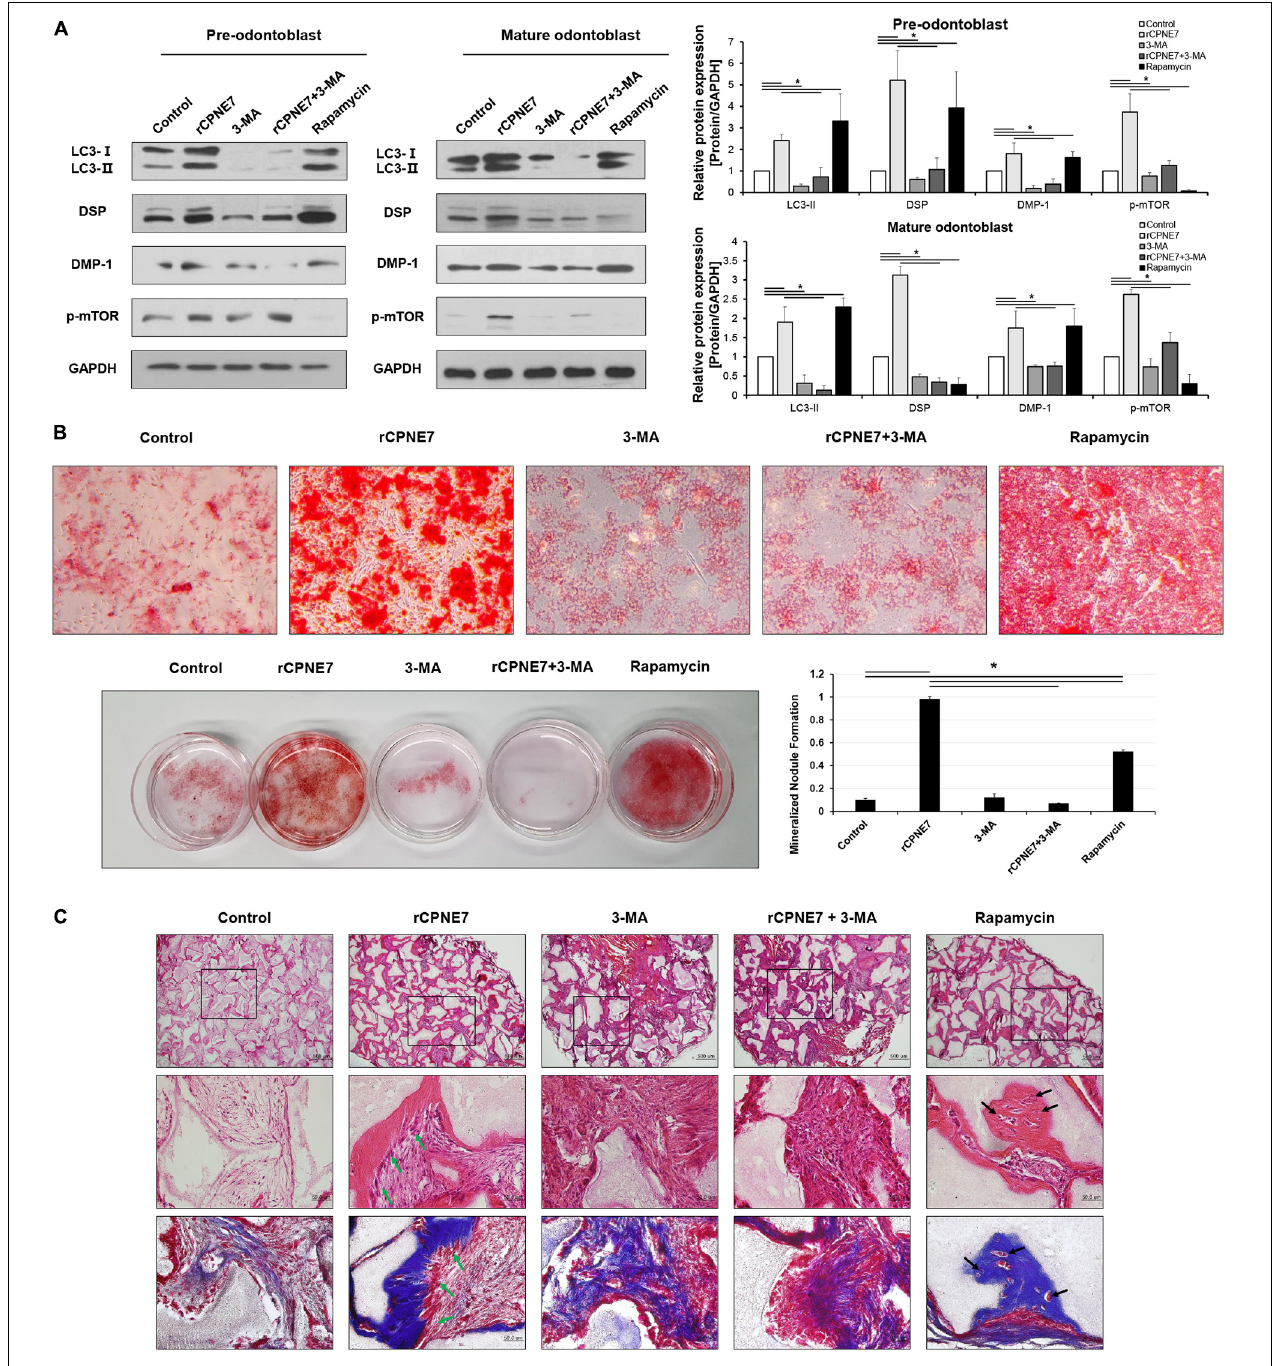
FIGURE 2 | CPNE7 promotes odontoblast differentiation and dentin formation by inducing autophagy in mature odontoblasts. (A) Both stages of hDPCs were treated with rCPNE7 (100 ng/ml), 3-MA (5 µ M), rCPNE7 + 3-MA, or rapamycin (10 nM) for 24 h. LC3 II, DSP, DMP-1, and p-mTOR protein levels were evaluated by western blot analysis. (B) Effects of rCPNE7, 3-MA, rCPNE7 + 3MA, and rapamycin on the mineralized nodule formation of mature hDPCs in vitro , as analyzed by alizarin red S staining. (C) Ectopic transplantation of mature odontoblasts treated with control (PBS), rCPNE7, 3-MA, rCPNE7 + 3-MA, or rapamycin and HA/TCP was histologically analyzed through H&E and Masson’s trichrome staining. Scale bars = 500 µ m. Boxed areas are shown at higher magnification. Scale bars = 50 µ m. Dentin-pulp-like structures (green arrows) were observed in the rCPNE7 groups. Cells entrapped in mineralized tissue (black arrows) were observed in the rapamycin groups. 3-MA, 3-methyladenine; DMP-1, dentin matrix protein 1; p-mTOR, phospho-mammalian target of rapamycin; HA/TCP, hydroxyapatite/tricalcium phosphate. Significant differences are shown with asterisks. * P < 0.05.